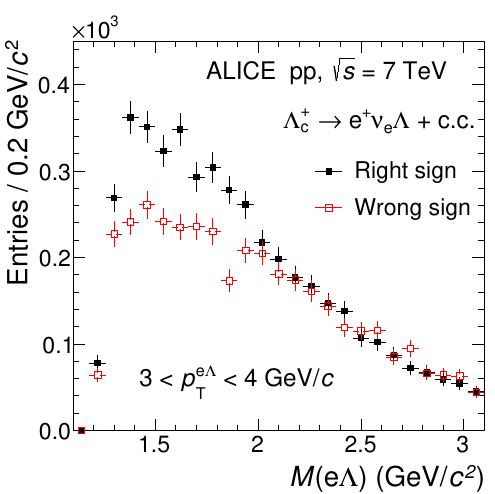
Figure 5 . Invariant mass distributions of e(cid:3) pairs for RS and WS combinations in the interval 3 < p e(cid:3) < 4 GeV/ c in pp collisions at T